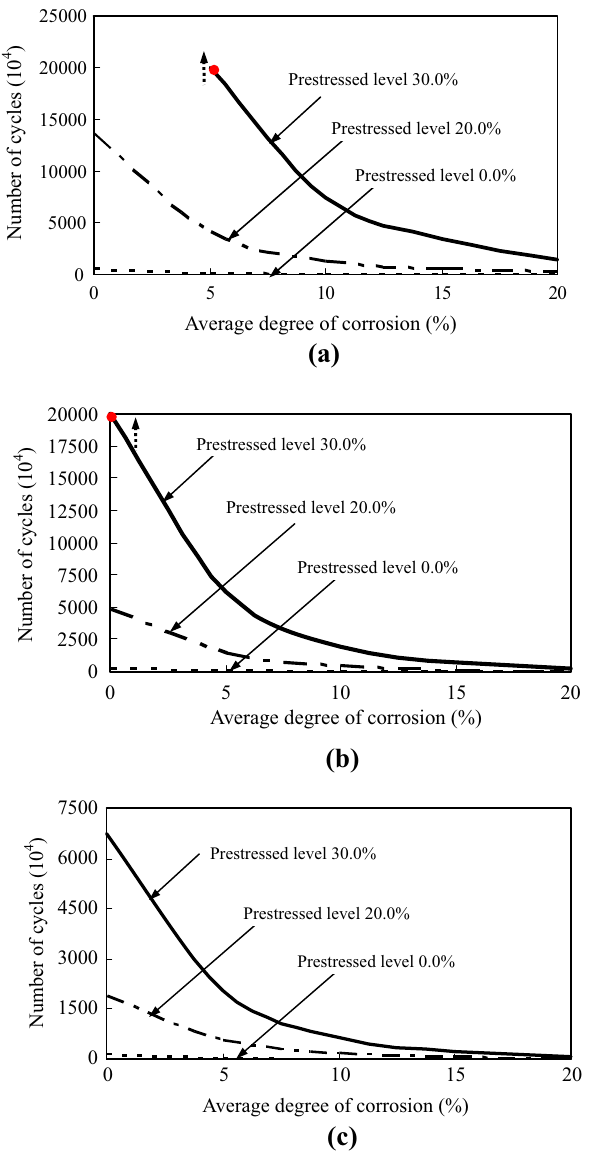
Fig. 5 Fatigue life versus average degree of corrosion: a 0.5 load level, b 0.55 load level, c 0.60 load